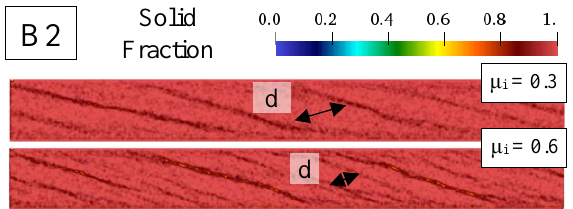
Fig. 4. Solid fraction as a function of a slip distance (mm) letter from figure 3, L 10.